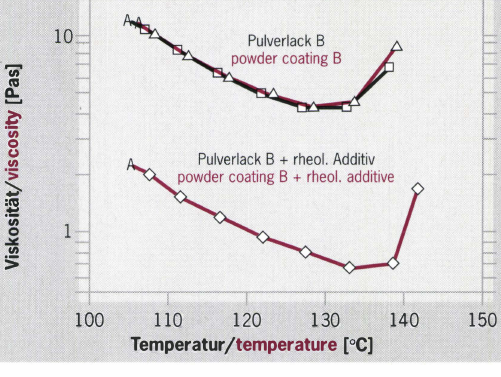
Fig. 7: Viscosity as a function of temperature for a standard powder coating used in series application